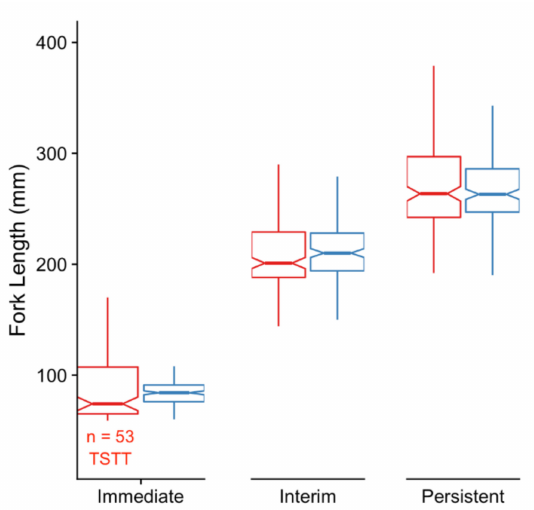
Figure 2. Fork length measurements of male fish that experienced early-rearing in either a stream (red) or hatchery (blue) environment at the Immediate (Feb 2015) and Persistent (Feb 2016) sampling time-points as well as an Interim time-point in September 2015. Fifty-three stream-reared males were not measured at the Immediate time-point as they were too small to tag (TSTT). The TSTT fish were subsequently tagged and measurements for these fish are included for the Interim and Persistent